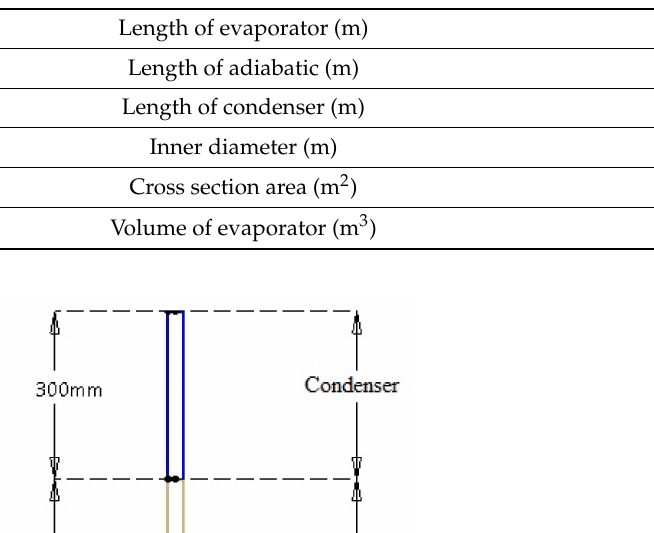
Table 6. Geometric characteristics of the TPCT in CFD study.